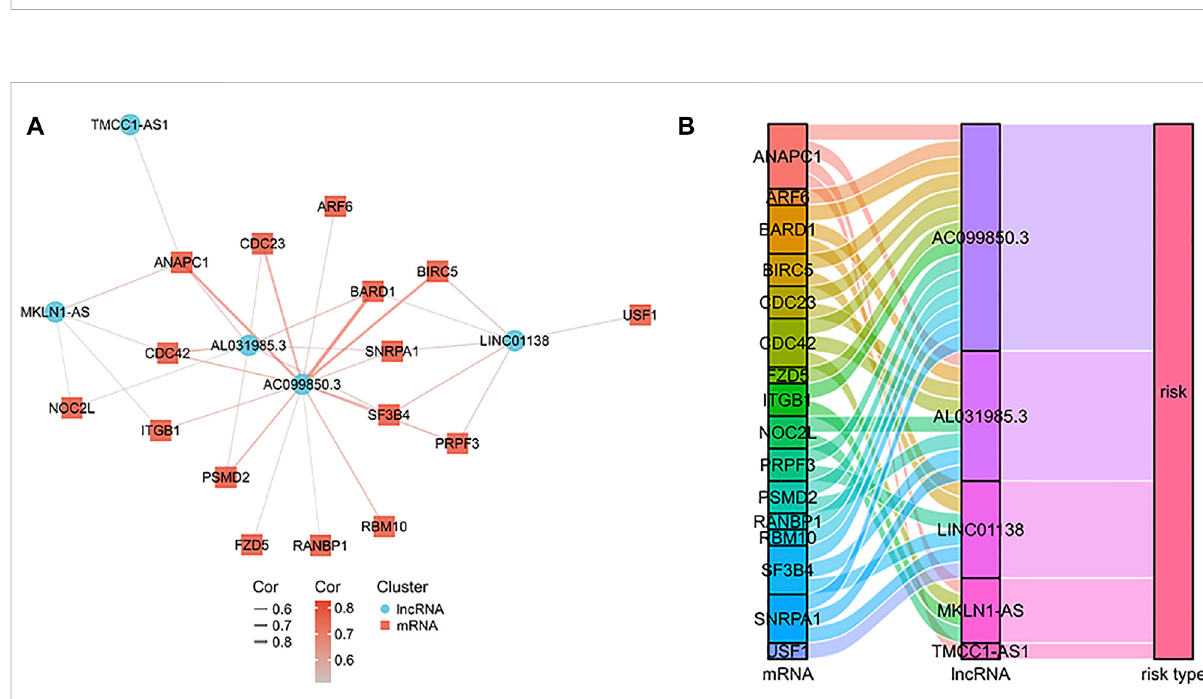
FIGURE 2 The mRNA-lncRNA co-expression network. (A) The co-expression network of the exosome-related genes and candidate lncRNAs. (B) Sankey diagram showing the connection degree between the exosome-related genes and candidate